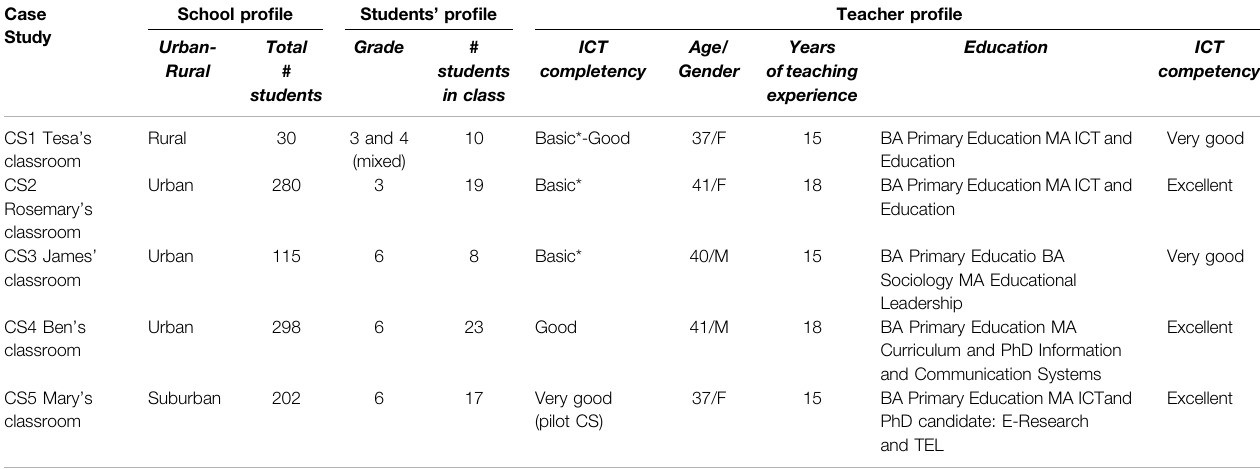
TABLE 1 | Case studies-pro fi le